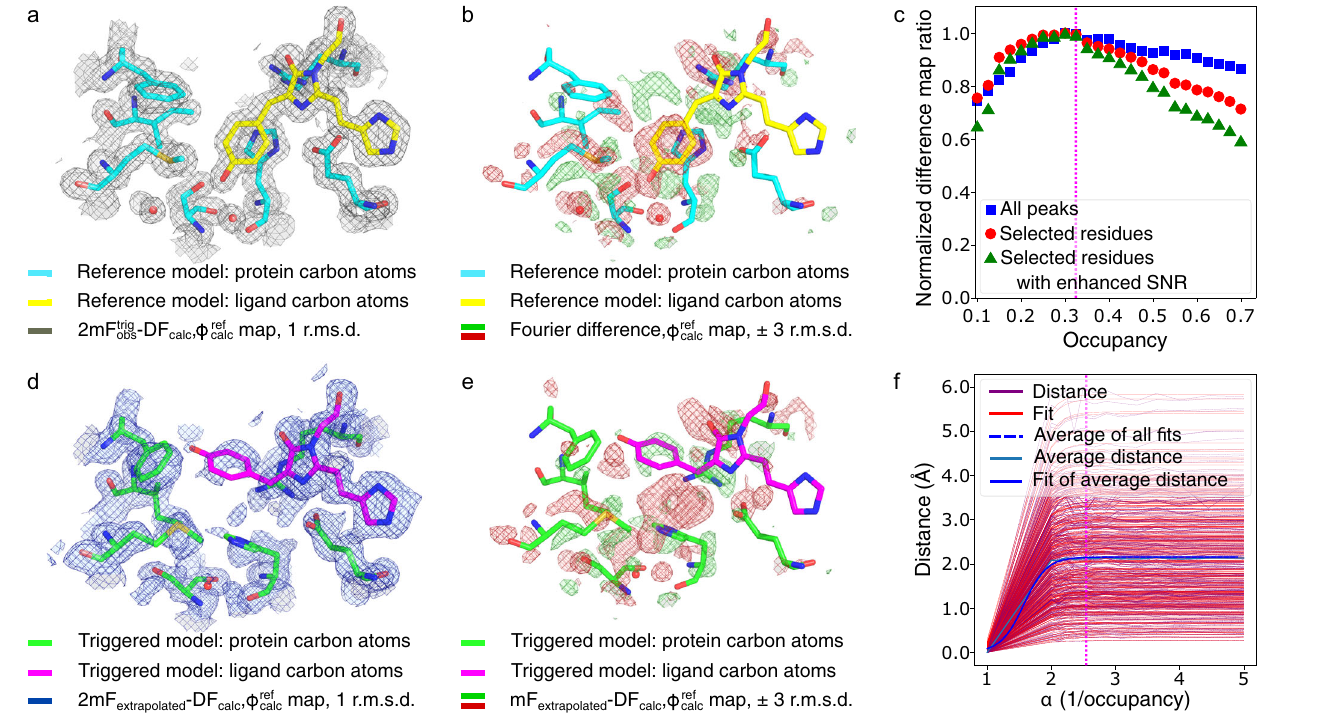
Fig. 4 Xtrapol8 enables successful extraction of the mEos4b red-off state. The models in cyan and green are mEos4b in the red-on and red-off state, respectively, as downloaded from the PDB (PDB entry 6GP0 and 6GP1, with the only difference that features of green mEos4b were omitted) with the chromophore indicated in yellow (reference state, a , b ) and magenta (triggered state, d – e ). a traditional 2mF obs − DF calc electron density after rigid body re fi nement of the red-on state model in the red-off data indicates the absence of signal for the red-off state. b q -weighted Fourier difference map (cid:1) F red (cid:1) on ( F red (cid:1) off ) superposed on the red-on model. c the difference-map method maximizes the information content of extrapolated difference maps and obs obs estimates the occupancy to be 0.325 (magenta dashed line). d – e Initial q -weighted 2mF extrapolated − DF calc ( d ) and mF extrapolated − DF calc ( e ) electron density maps calculated for an occupancy of 0.325 superposed on the red-off model. f The distance-analysis method, which approximates the correct occupancy by fi tting a sigmoid to the evolution of interatomic distances as a function of all tested occupancies and then retrieves the occupancy value for which 99% of the plateau is reached, returns an occupancy estimate of